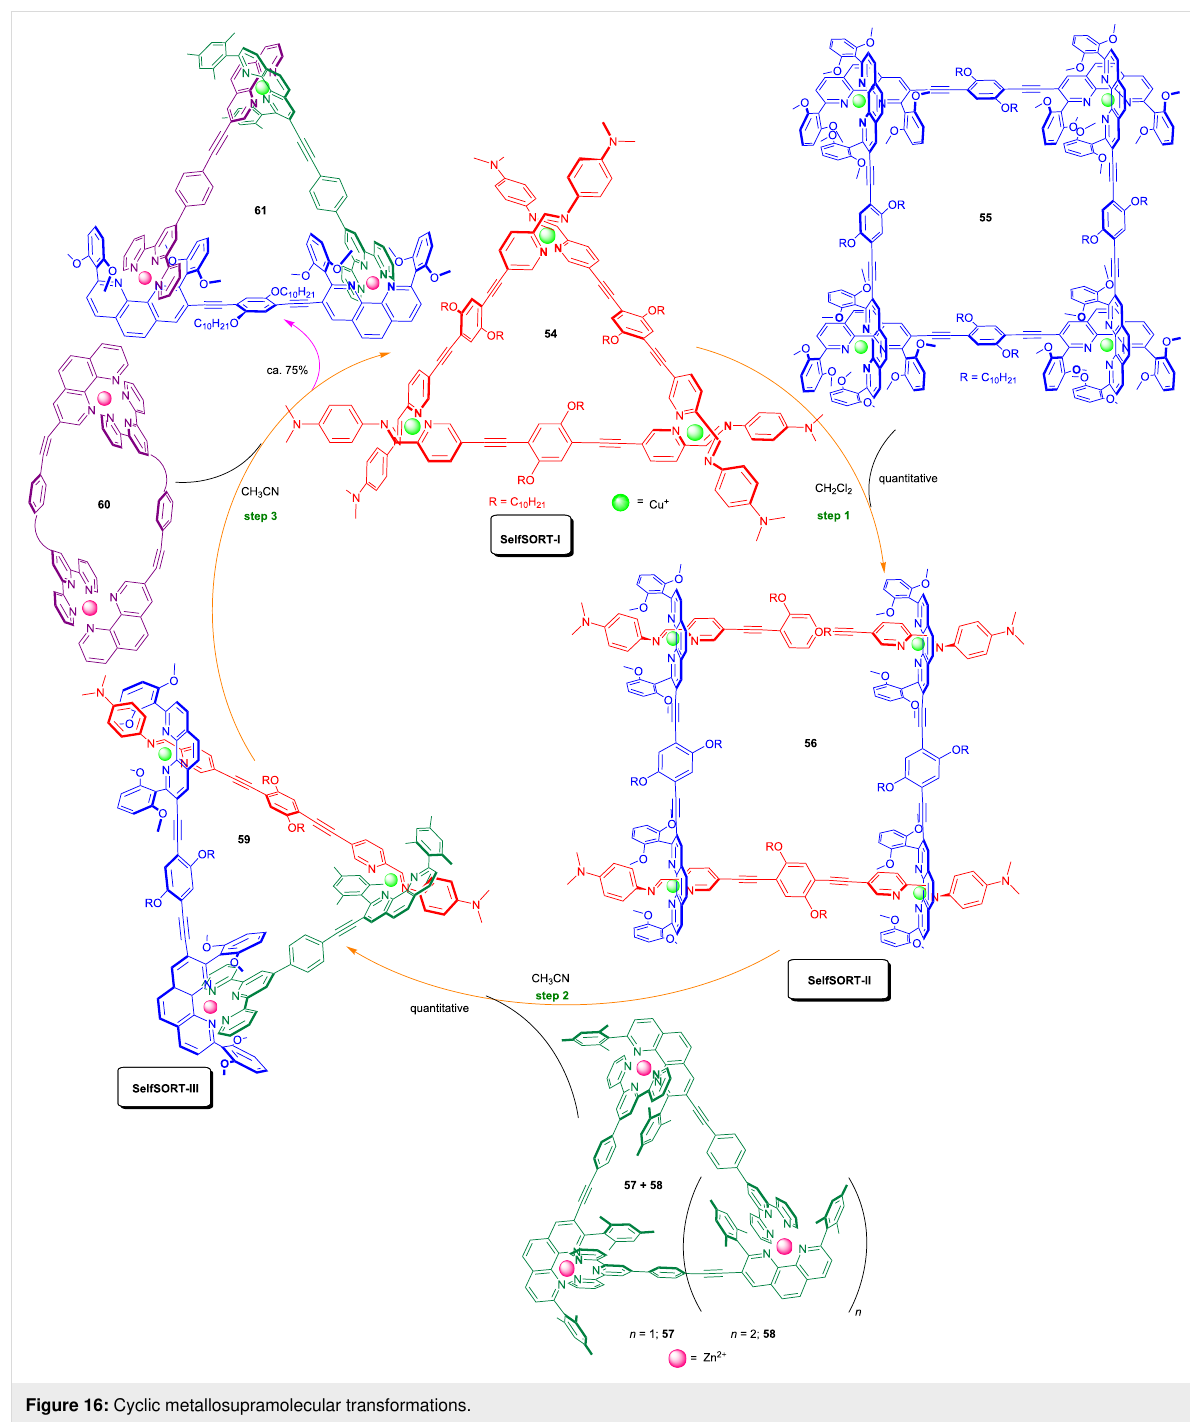
Figure 16: Cyclic metallosupramolecular transformations.